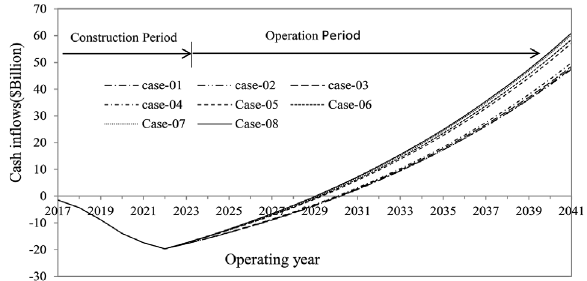
Figure 12. Cumulative cash inflows profile of the Rooppur NPP project (Billion USD).